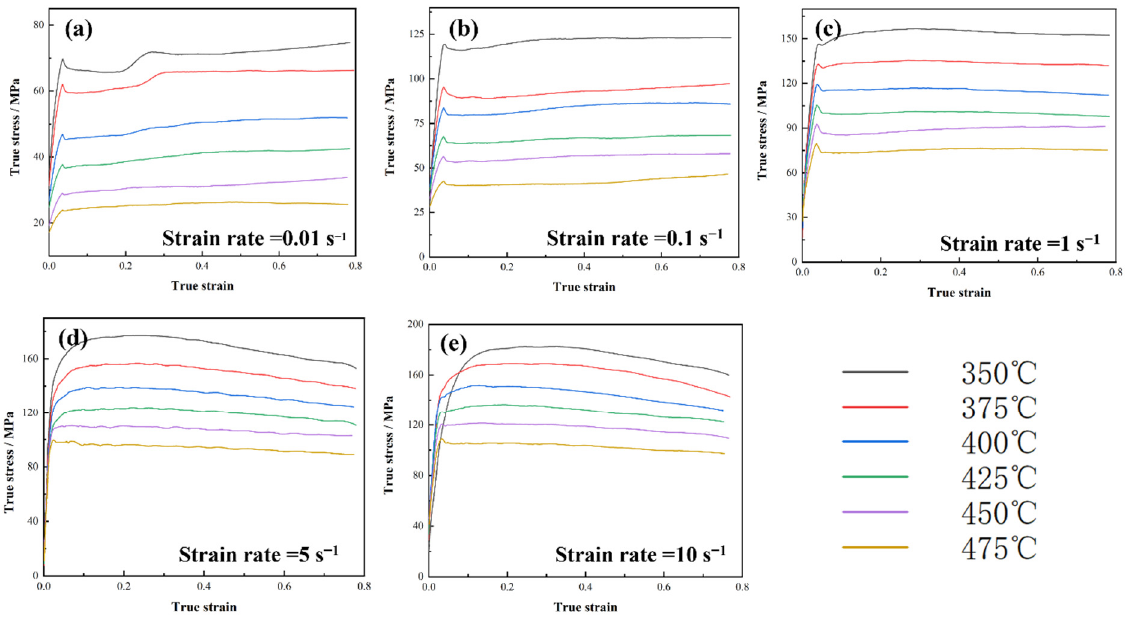
Figure 2. Flow stress curves of the 1420 Al–Li alloy. ( a )strain rate = 0.01s − 1 ; ( b ) strain rate = 0.1s − 1 ; ( c ) strain rate = 1s − 1 ; ( d ) strain rate = 5s − 1 ; ( e ) strain rate = 10s − 1